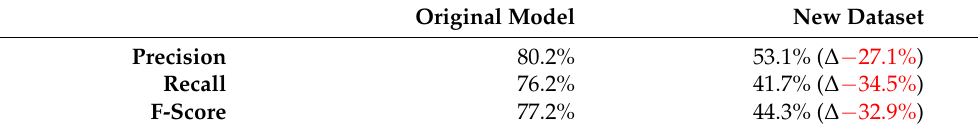
Table 1. Results of accuracy drop against a new dataset collected over long-term